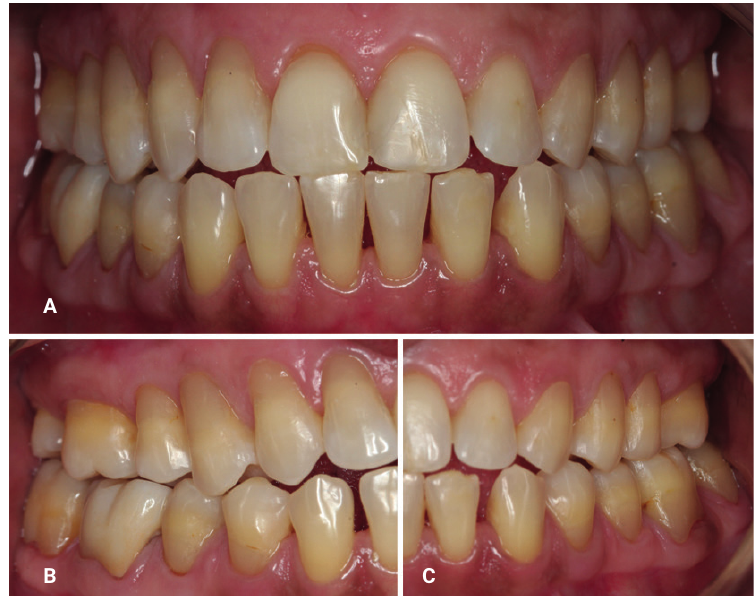
Figure 7. Aspects of the restorations after 1-year follow up. (a) Frontal view of restoration in function after 1-year placement. (b) Left view of restorations. The crown and Class V restorations well adapted. (c) Right view of restorations. Class V restorations without margin cracks and presenting good